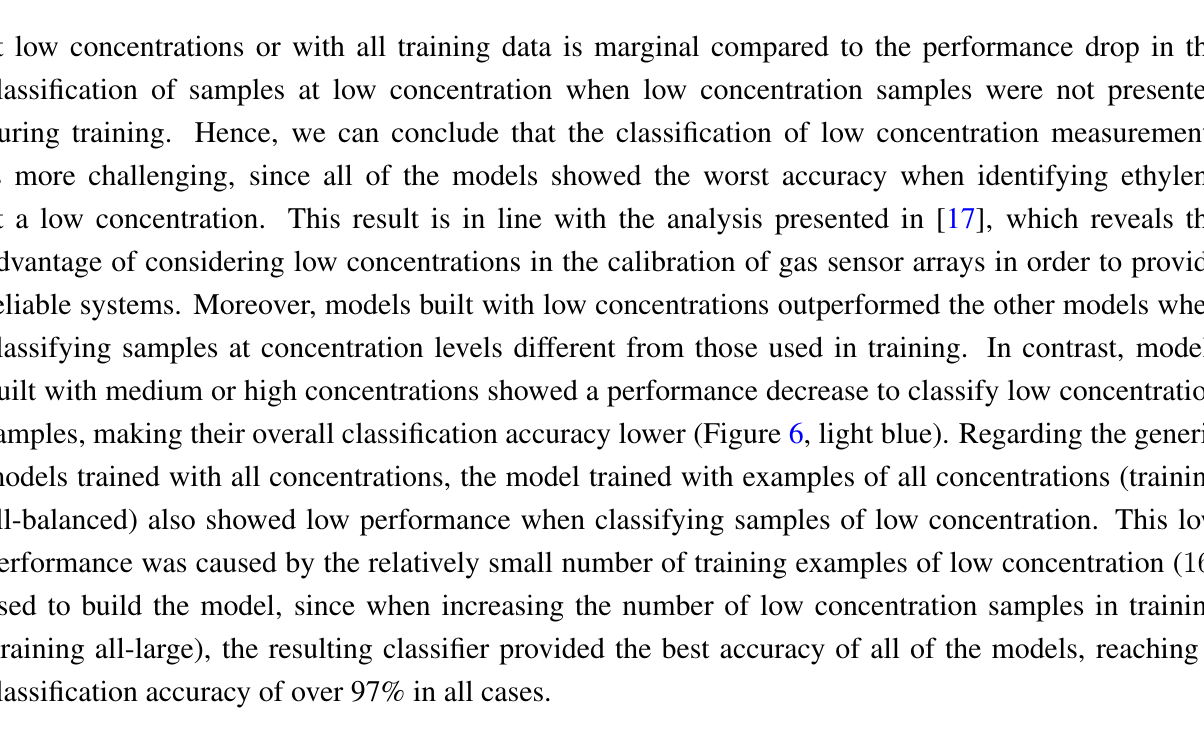
Figure 6. Accuracy of the classifiers when trained under different concentration ranges. Each binary classifier was built with a different training dataset: combining samples without ethylene with samples at either low, medium or high concentration levels (‘Low’, ‘Medium’, ‘High’), with 48 training examples of all ethylene concentrations (‘all-balanced’) and with 150 samples of all ethylene concentrations (‘all-large’). The accuracy in cross-validation is presented (dark blue). Each classifier was tested over the whole test dataset containing samples of all concentrations (light blue) and using only low (green), medium (orange) or high (dark red) ethylene concentration test